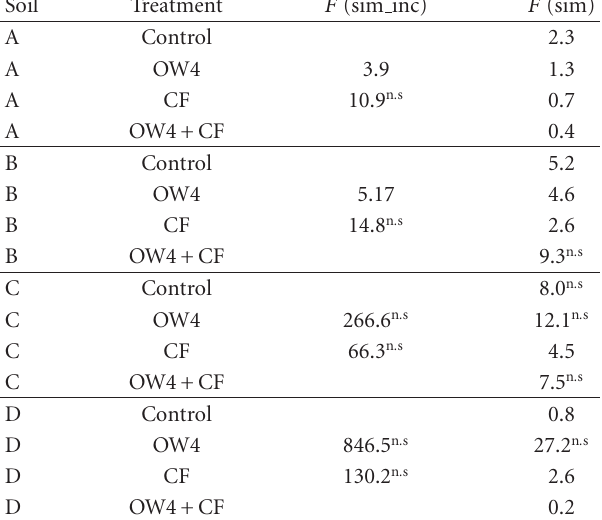
Table 9: F -values used for evaluation of LOFIT. “n.s” = not significant at 10% level, (sim cal) refers to the sim inc. simulation results (line Sim inc) presented in Figures 3–6, that is, simulation with pools and parameters calibrated to data from the laboratory incubation experiment, and (sim) refers simulations based on new calibration of pools and parameters in order to achieve optimal